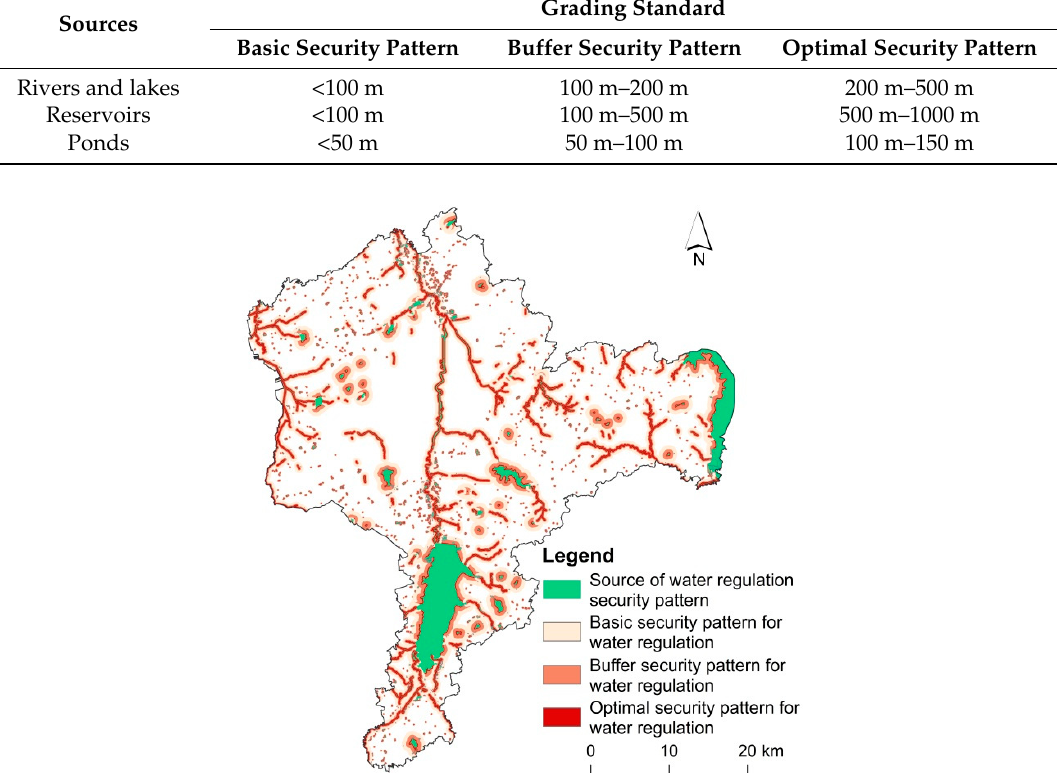
Table 1. Grading standard for water regulation security pattern of basic, buffer and optimal levels.